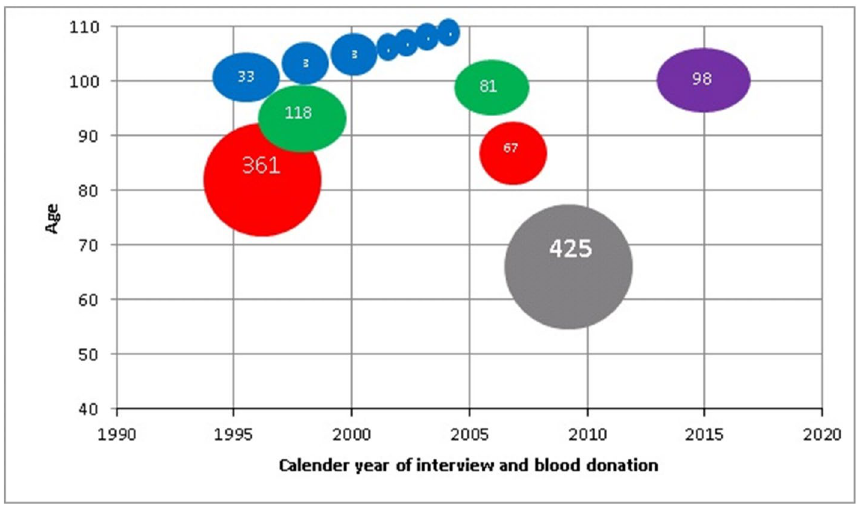
Figure 1. Lexis diagram of populations of women with measured degree of skewed X-inactivation. Blue: 1895 birth cohort with repeated measures at the latest follow-up participation. Green: 1905 birth cohort (cross- sectional). Note There are no repeated measures, thus the 1905 cohort is not included in longitudinal studies. Purple: 1915 birth cohort (cross-sectional). Red: LSADT with repeated measures at follow-up. Gray: MADT (cross-sectional).